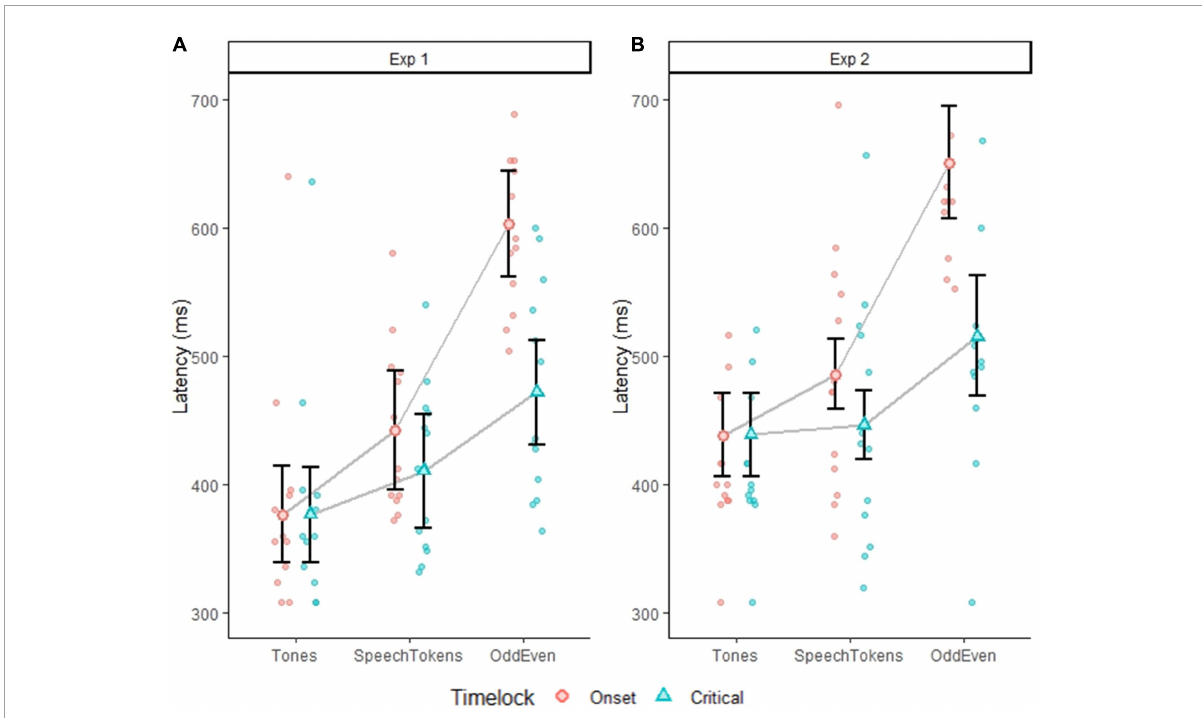
FIGURE3 Plots depict the average P3b peak latency for all three tasks average on a subject level. Error bars represent the standard error of the mean. (A) Depicts the difference in P3b peak latency for experiment 1 when time locked to onset (red dots) and critical latency (blue dots). (B) Depicts the difference in P3b peak latency for experiment 2 when time locked to onset (red dots) and critical latency (blue dots). Faded red and blue dots represent each subject P3b